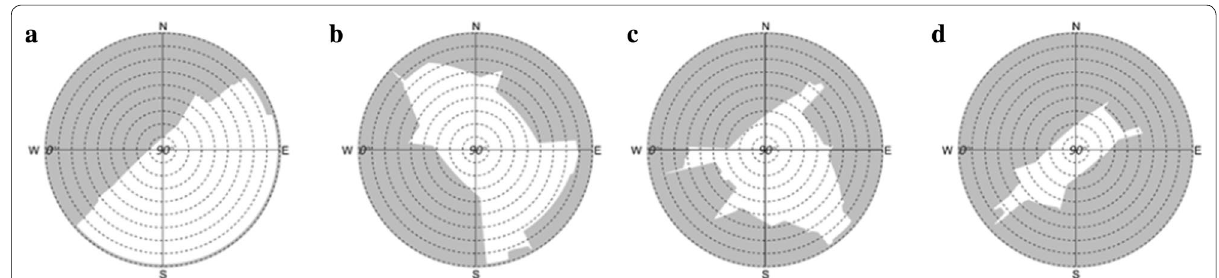
Fig. 8 The sky plots with building boundaries of different location in the urban canyon. a One side of sky is blocked (P6). b Two sides of sky is blocked (P5). c Three sides of sky is blocked (P3). d Four sides of sky is blocked (P7)